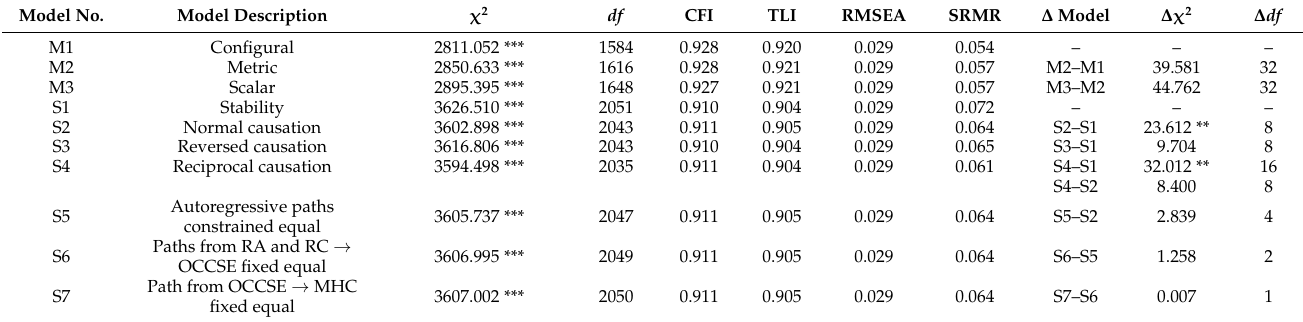
Note: N = 917 (missing data were treated using the FIML estimation). RA = role ambiguity, RC = role conflict, OCCSE = occupational self-efficacy, MHC = mental health complaints. CFI = Comparative Fit Index, TLI = Tucker-Lewis Index, RMSEA = root mean squared error of approximation, SRMR = standardized root mean squared residual. ** p < 0.01, *** p <